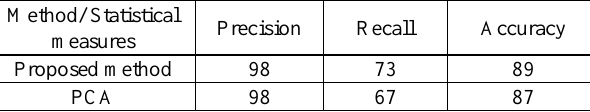
Table 5. Results of check point analysis using Leica subset